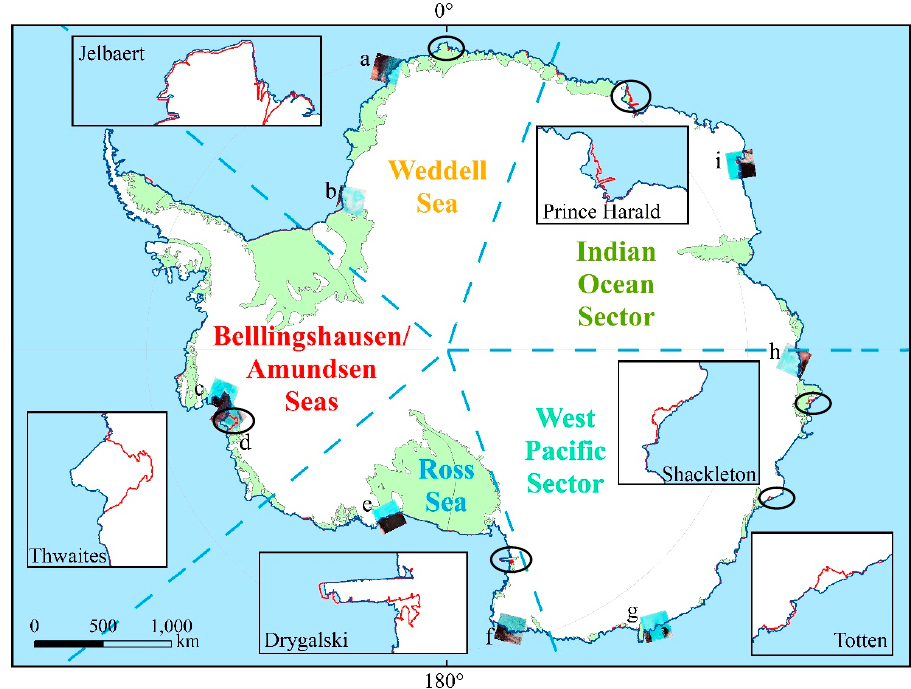
Figure 3. Coastline from the present method (blue) compared to the 2004 Mosaic of Antarctica (MOA) coastline (red) for the entire Antarctic. The green color indicates the geolocations of ice shelves around the Antarctica. Samples from each sector that highlight areas of remarkable difference between the two data sets are shown in the insets. Also, marked by footprints of Landsat images are locations of nine areas (a-i) where statistical analysis of the difference between the automated and manually extracted coastline was performed. The zoomed in Landsat images of the nine areas are illustrated in Figure 4.